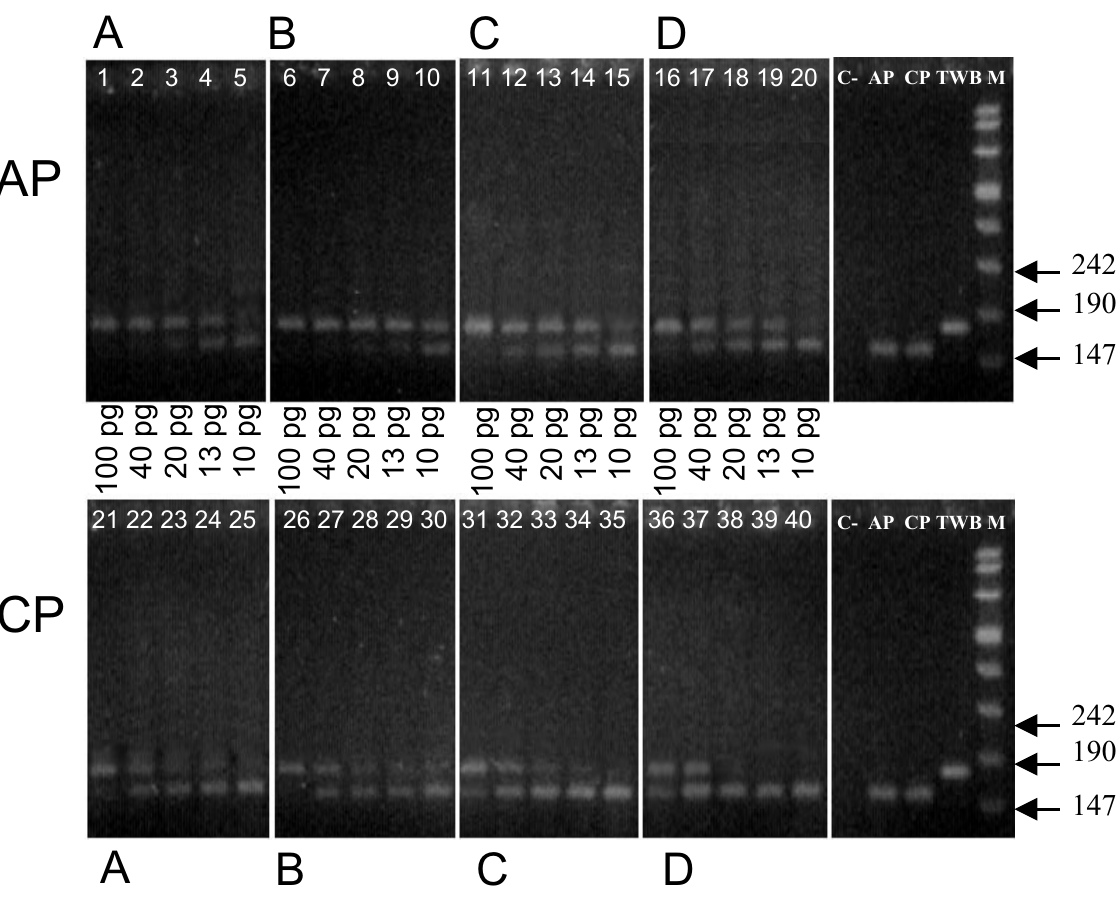
Fig. 3. Gel electrophoresis of the competitive PCR amplification products obtained with the third series of the DNA extractions. The DNA obtained with the four extraction techniques from plants infected with AP-phytoplasma (top: method A, lanes 1–5; B, lanes 6–10; C, lanes 11–15; D, lanes 16–20) and CP-phytoplasma (bottom: method A, lanes 1–5; B, lanes 6–10; C, lanes 11–15; D, lanes 16–20) was amplified in the presence of serial dilutions of competitor DNA. The dilutions of the competitor DNA are shown and expressed as pg. Lane C-: negative control. Lanes AP, CP, TWB: positive control for AP, CP and TWB phytoplasma DNA. Lane M: molecular size Marker VIII (Roche diagnos- tic, Mannheim,